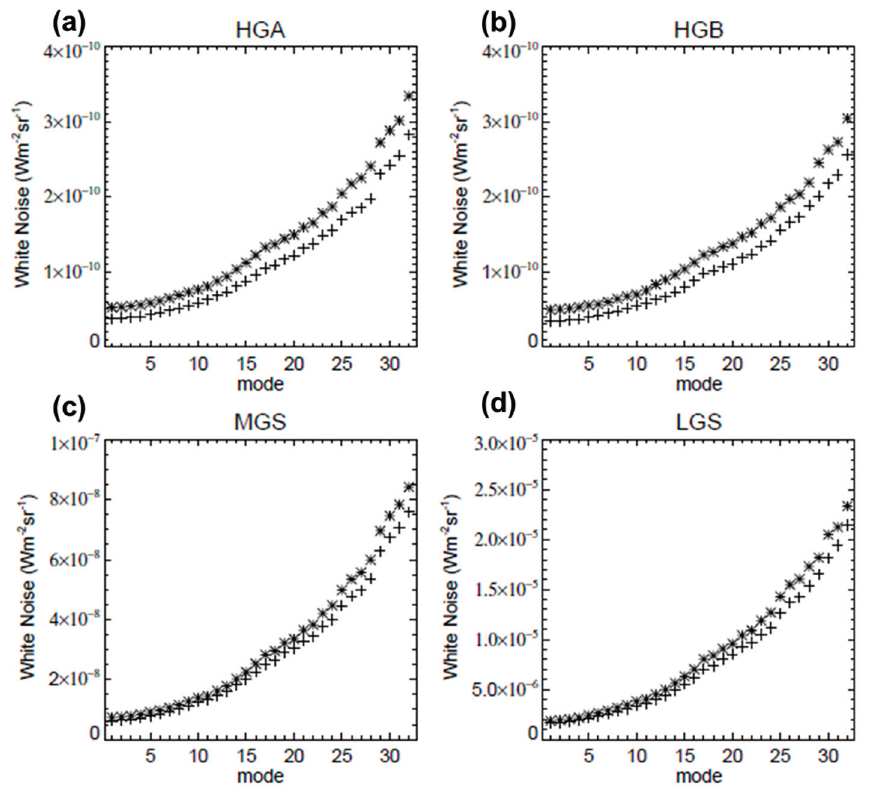
Figure 9. Detector averaged white noise computed from BB view data during February 2012 (+), and August 2014 (*). HGA, HGB, MGS and LGS are shown from ( a ) to ( d ), respectively. The x-axis indicates the DNB aggregation modes, where Modes 1 to 32 are used to collect data from nadir to the edge of the scan (see Figure 10).